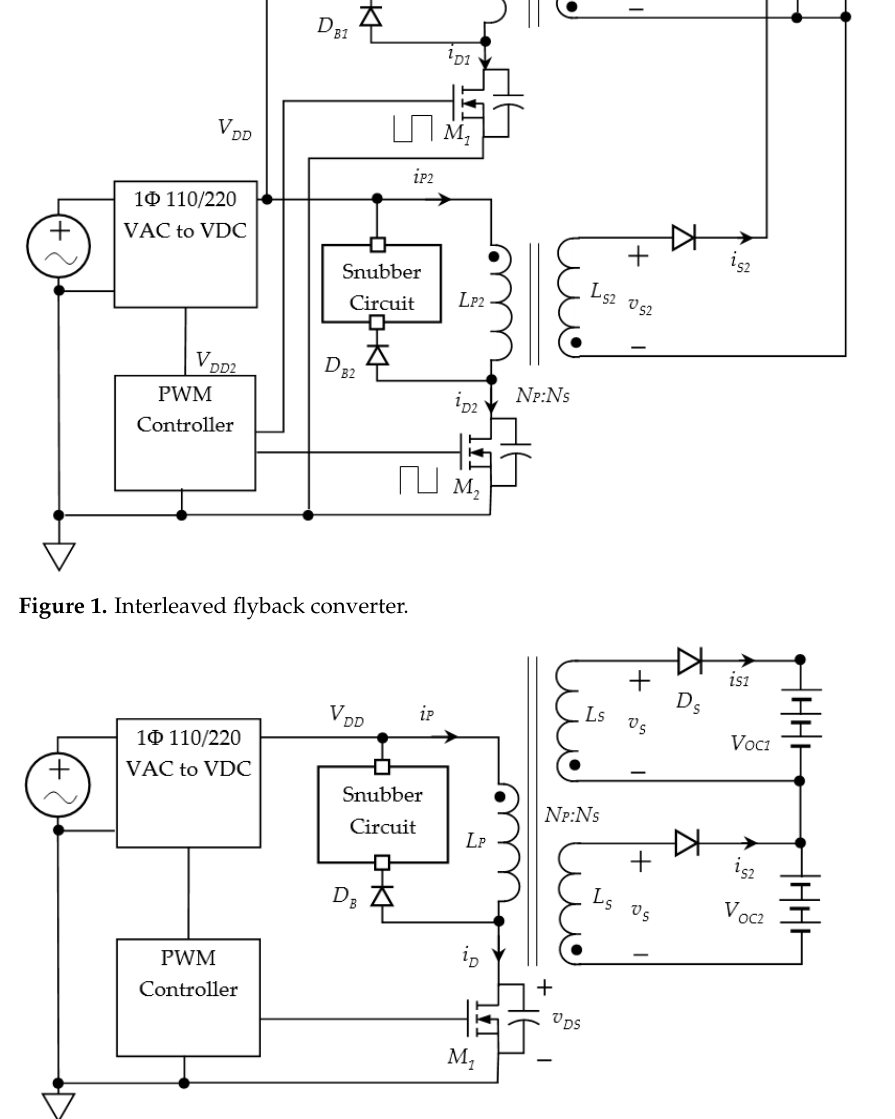
Figure 1. Interleaved flyback converter.